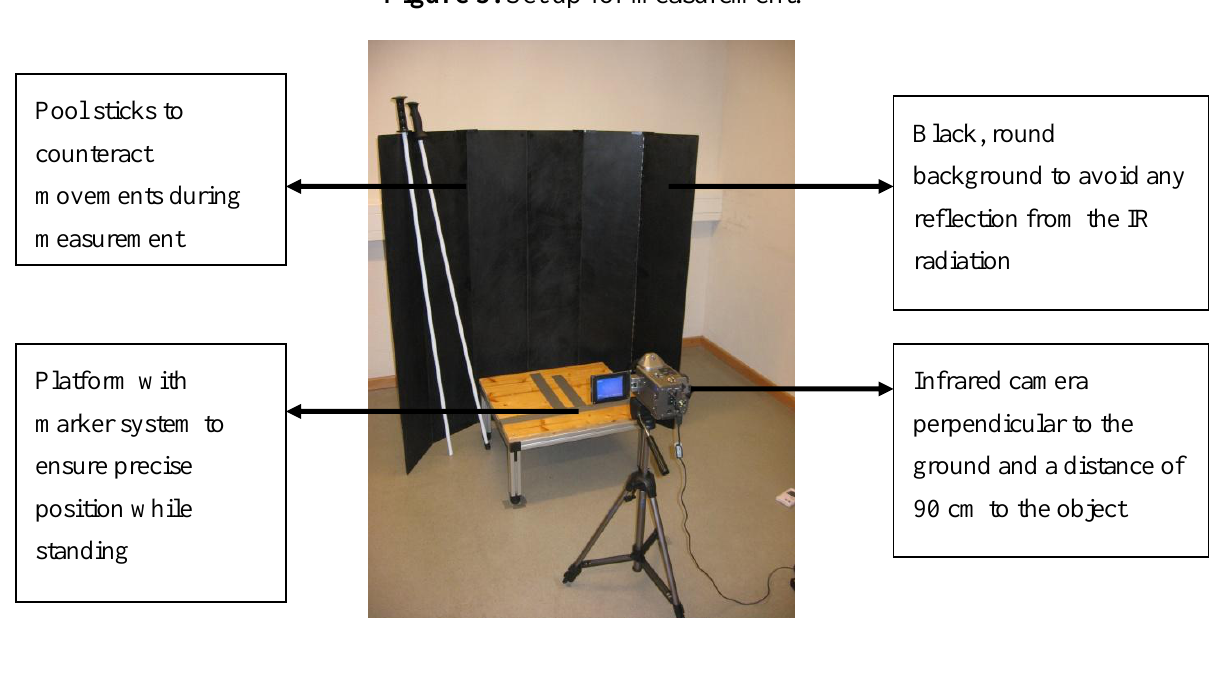
Figure 3. Set up for